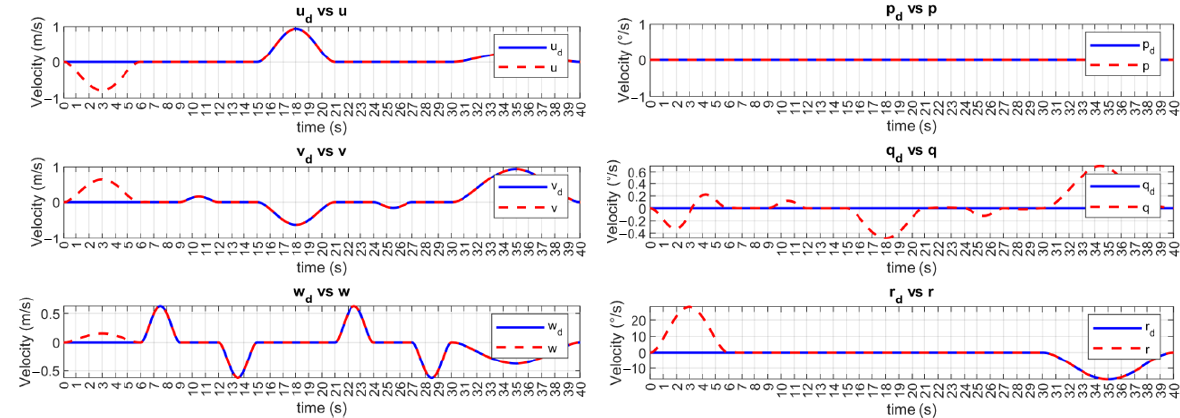
Figure 8. BlueROV2 #2 velocity tracking with the MFSOSMC (no external disturbances).